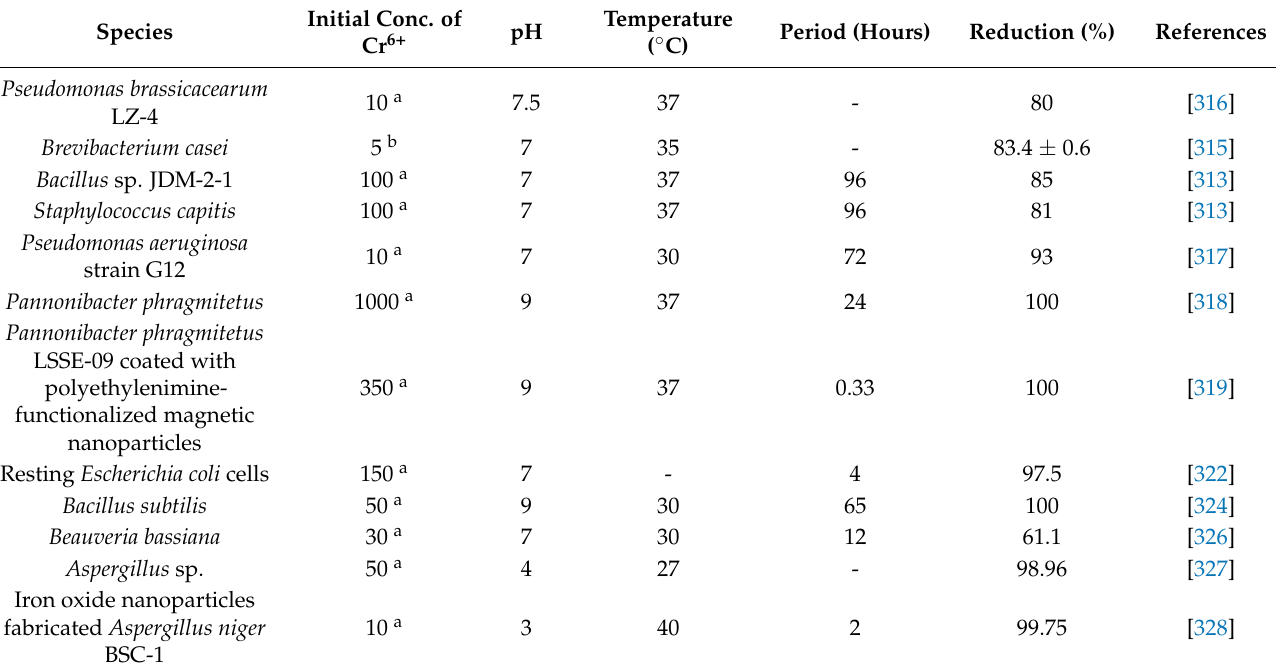
Table 6. Biological removal of Cr 6+ in different literature (the superscript “a” denotes in mg/g). Initial Conc. Species